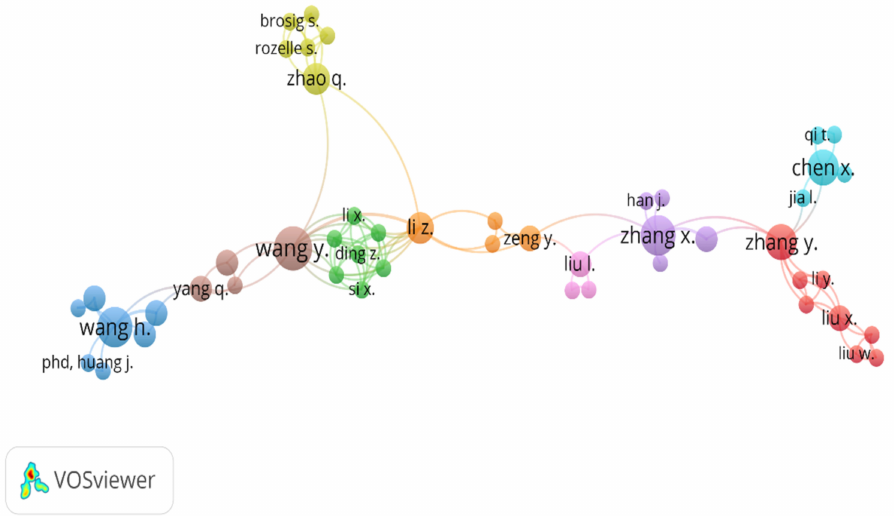
Figure 6. Network of cooperation based on co-authorship of the principal authors. Source: own elaboration. Each of the colours corresponds to a cluster grouping its main collaborators.